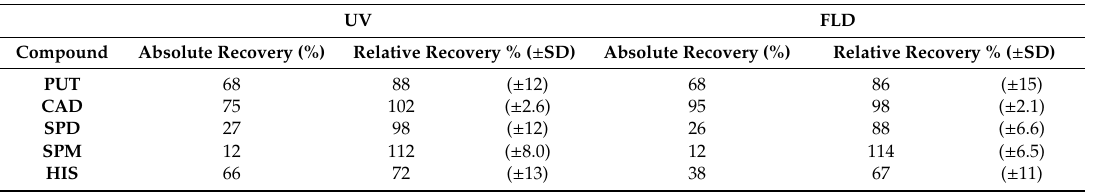
Table 7. Absolute and relative recoveries of each compound from spiked sea bass sample at six di ff erent